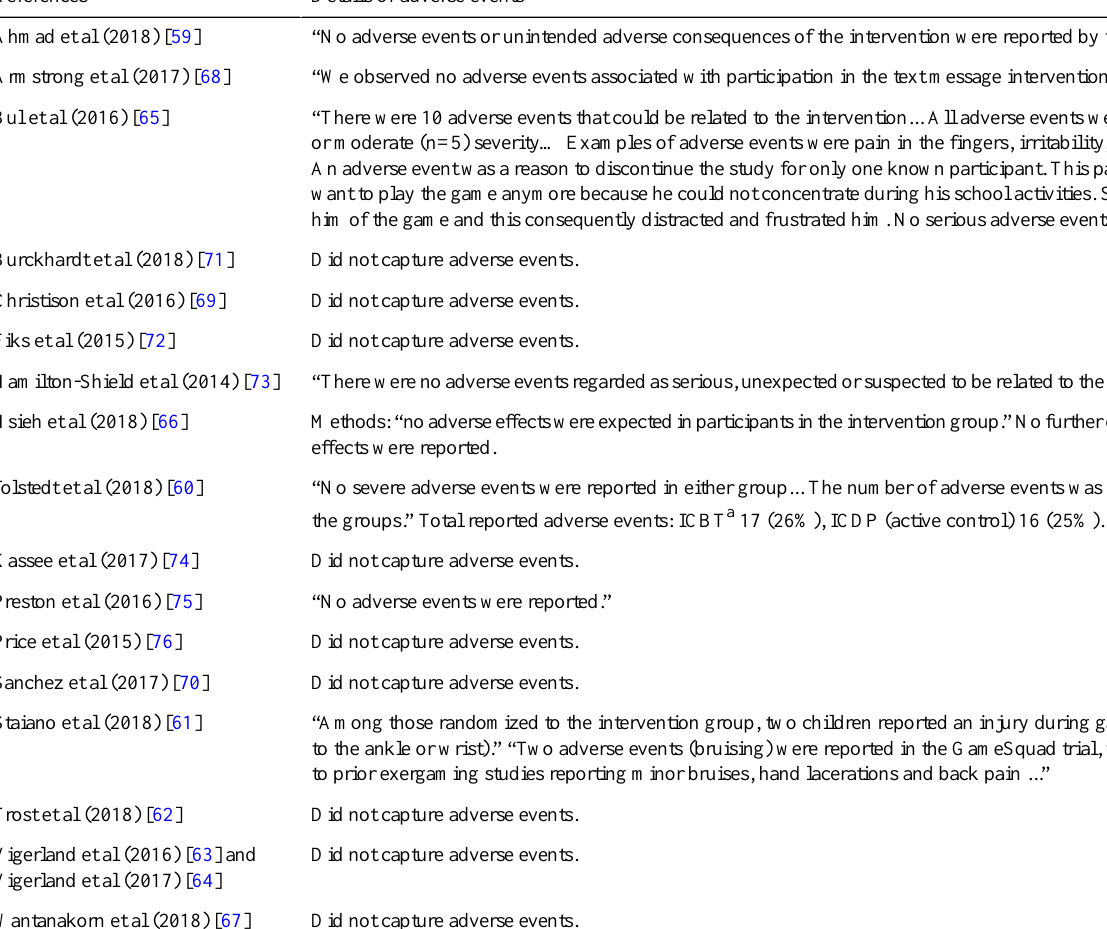
Table 3. Summary of adverse